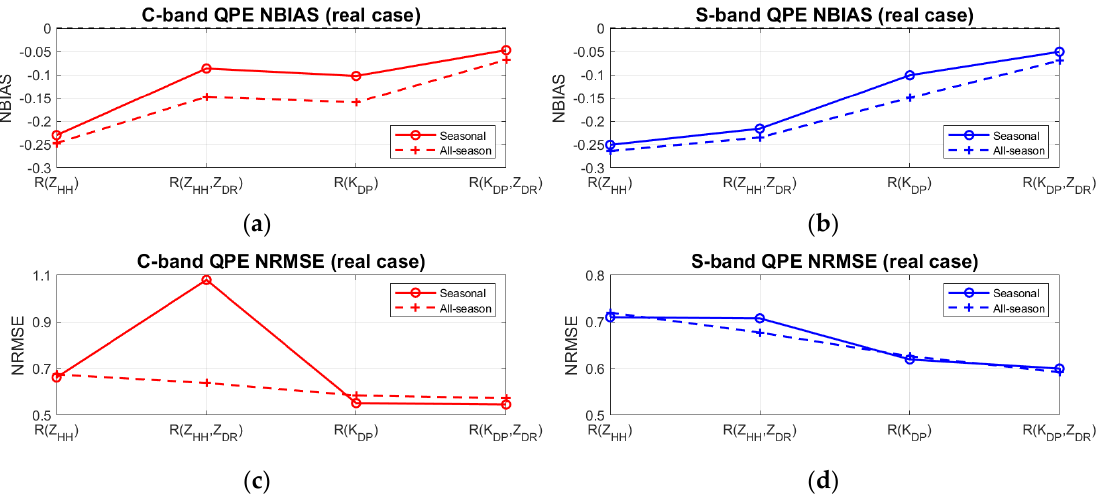
Figure 7. Same as Figure 4 but from real cases. Eighteen heavy precipitation events observed by NCU C-POL and RCWF are evaluated via rain gauge measurements.